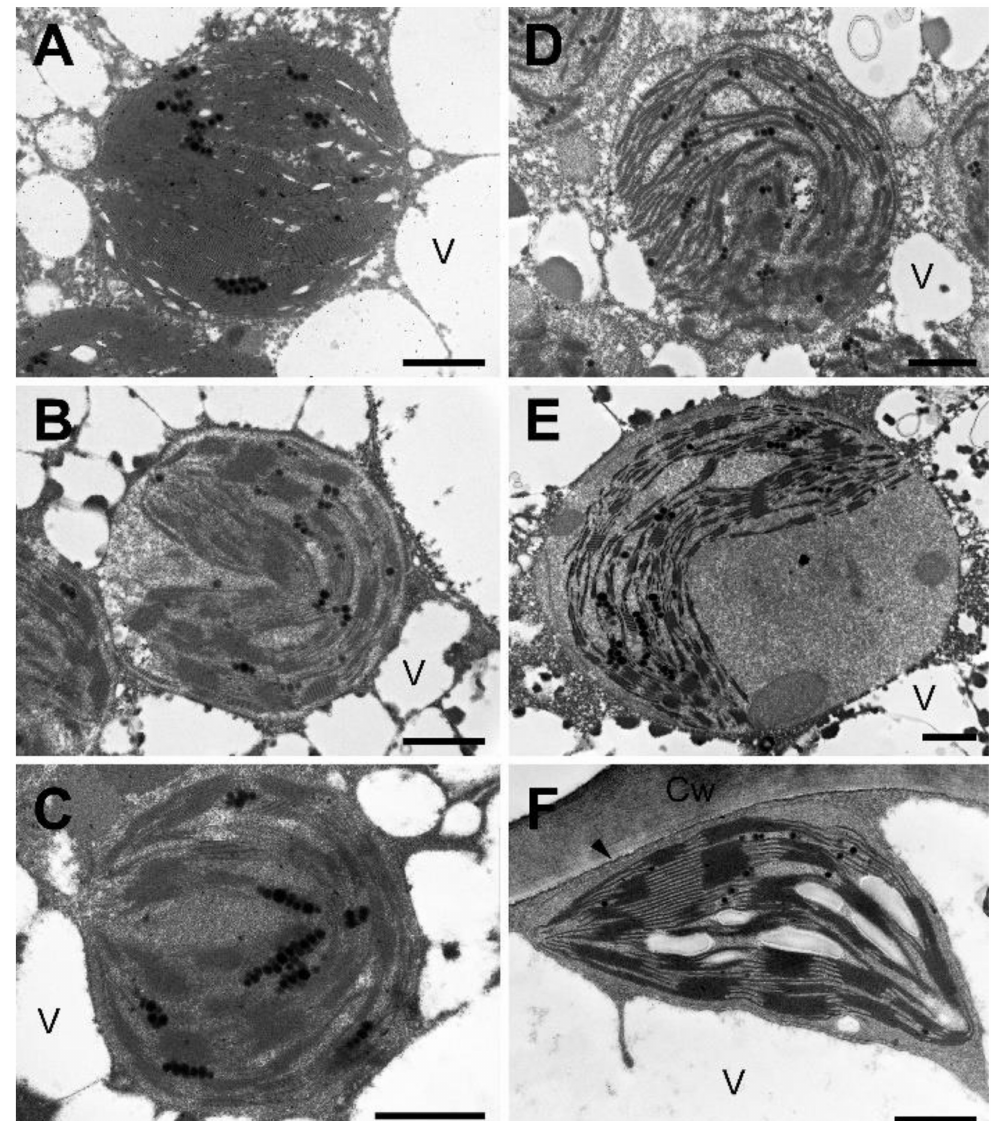
Figure 4. Chloroplast ultrastructure during recovery from freezing-induced desiccation (RAF) of H. rhodopensis leaves. ( A ): 0 h, ( B ): 1 h, ( C ): 5 h, ( D ): 9 h, ( E ): 15 h, and ( F ): 24 h after rehydration. Arrowhead: plasma membrane; Cw: cell wall; V: vacuole. Scale bar is equal to 1 µ